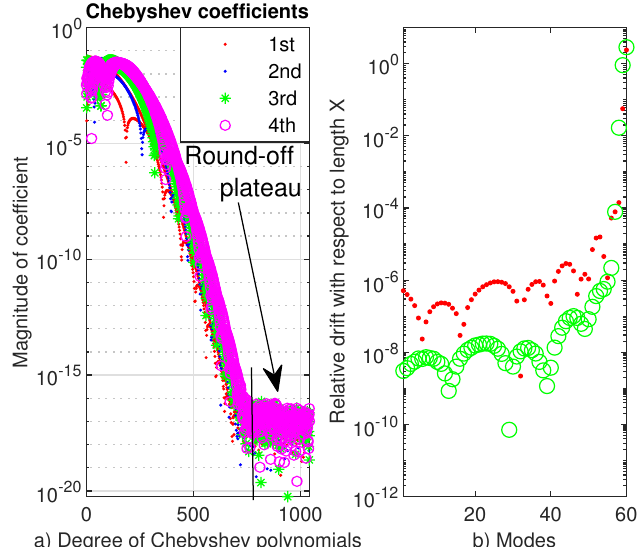
Figure 6. ( a ) In a log-linear plot, the Chebyshev coefficients of the first four eigenvectors of problem (1) equipped with the Morse potential (4). ( b ) The relative drift of the negative eigenvalues of this problem with respect to the length of the interval of integration X ; red dots correspond to X 1 : = 6.5 and X 2 : = 7.5, and the green circles correspond to X 1 : = 6.5 and to X 2 : =